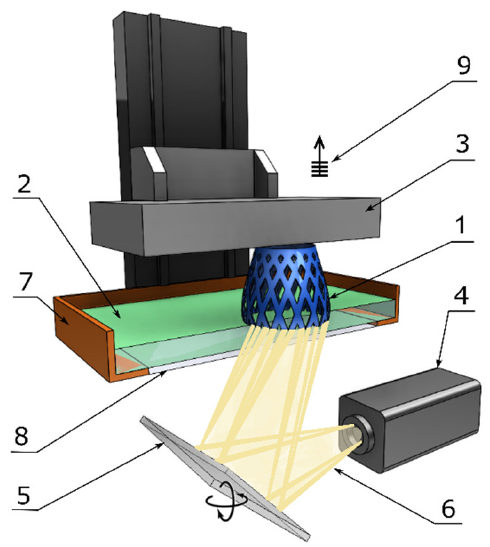
Figure 6. Components of a typical DLP machine: 1—printed part, 2—liquid resin, 3—building platform, 4—light source, 5—digital projector, 6—light beam, 7—resin tank, 8—window, and 9— layer-by-layer elevation.